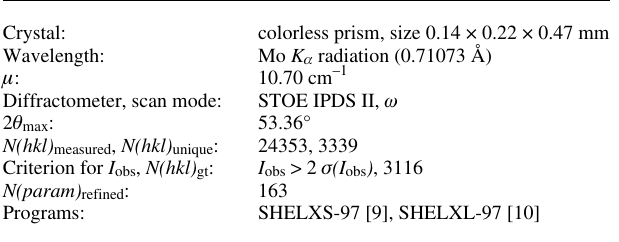
Table 1. Data collection and